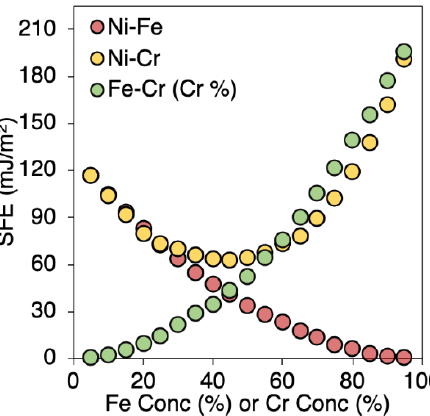
Figure 7. Effect of alloy chemistry on the average SFE in Ni-Fe, Ni-Cr, and Fe-Cr alloys computed in 108,000-atom supercells. Data from Figure 6 is used to calculate the average for each alloy chemistry. The SFE for Ni-Fe and Fe-Cr system varies almost linearly in contrast to parabolic behavior in Ni-Cr.